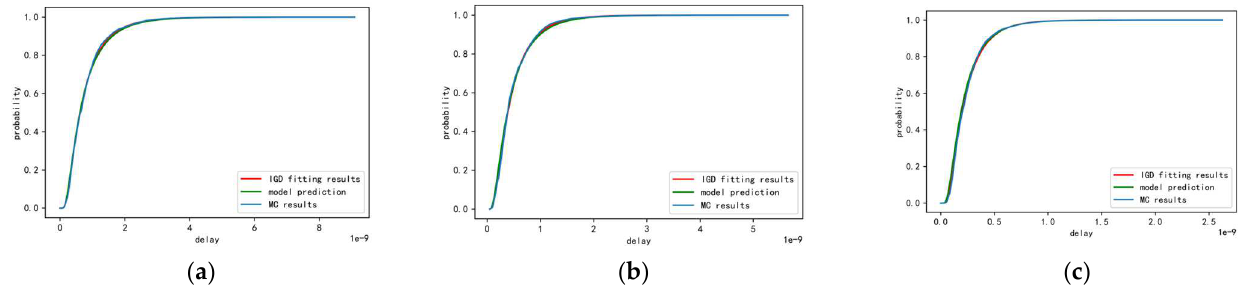
Figure 14. CDF curves comparison among MC simulation, IGD fitting and IGD delay modeling prediction ( a ) Vgs = 0.25 V; ( b ) Vgs = 0.27 V; ( c ) Vgs = 0.30 V.